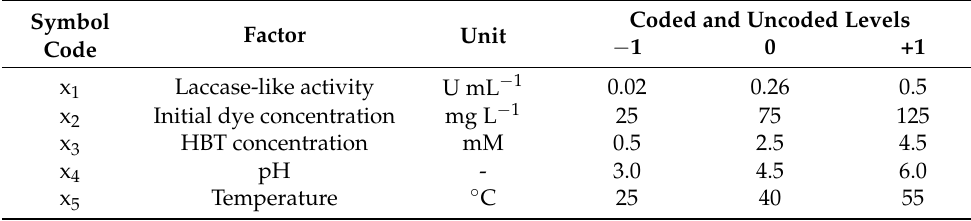
Table 2. Levels of factors tested in the screening design.